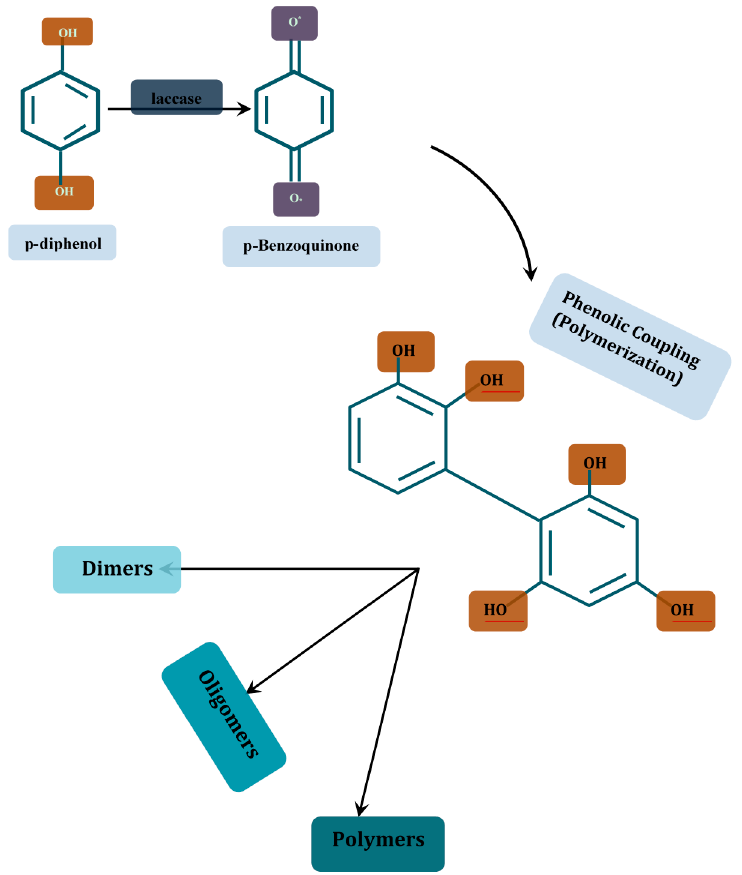
Figure 5. The polymerization of phenolic radicals generated from xenobiotics degradation.